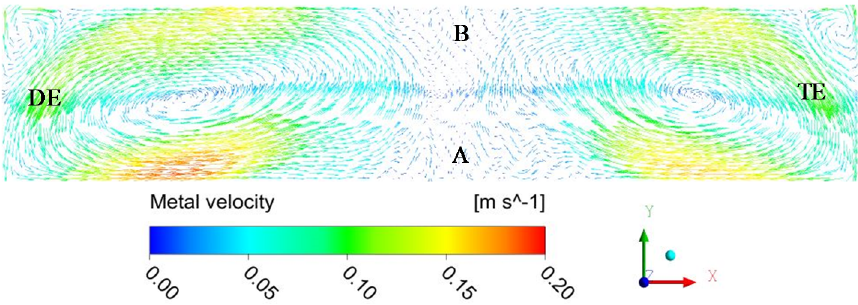
Figure 2. Metal flow field distribution of reference state (m/s).